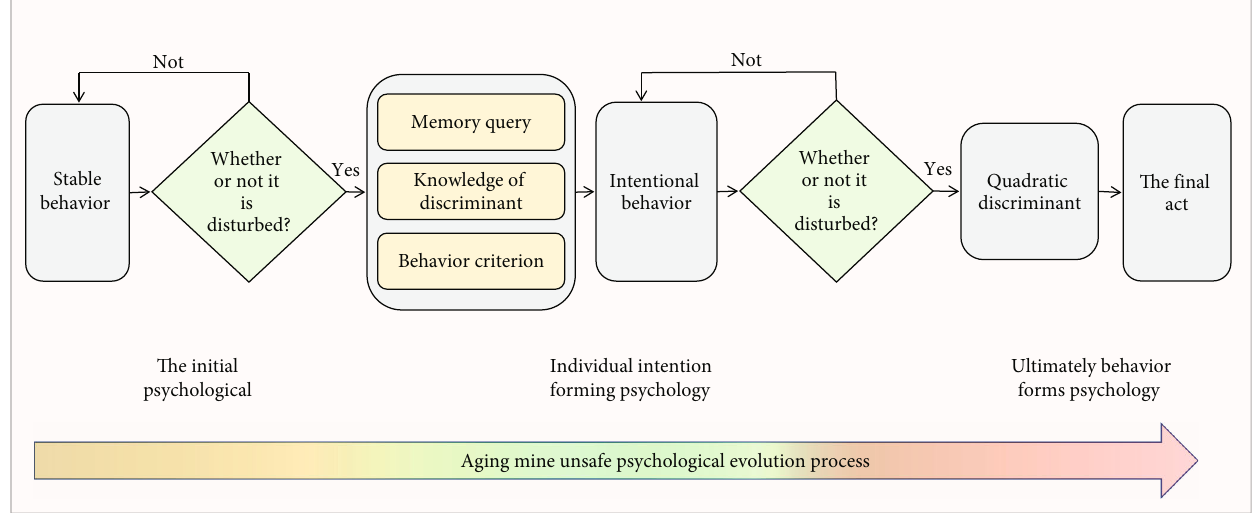
Figure 2: Mechanism diagram of unsafe psychological generation in the aging mine